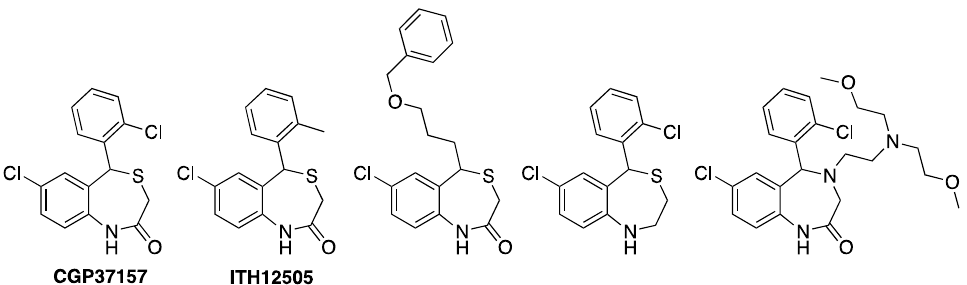
Figure 1. Chemical structures of CGP37157 and selected first generation analogues prepared, showing IC 50 values to block NCLX in pancreatic cells between 2 and 7 nM [CGP37157, 1.4 nM)]